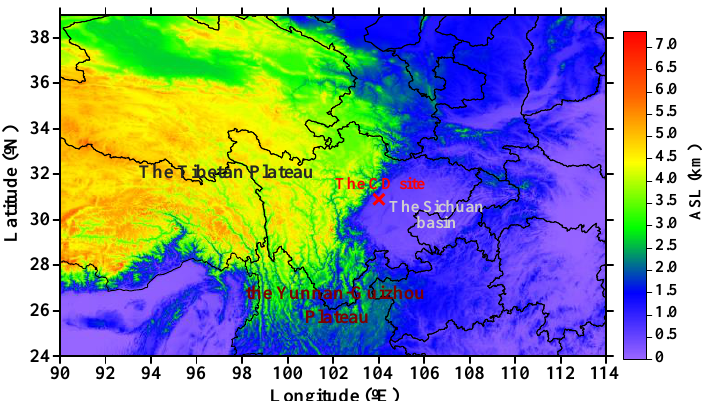
Figure 1. The position and surrounding topography of the observation site of Chengdu (CD, 30.75° N, 103.86° E, 549 m ASL).